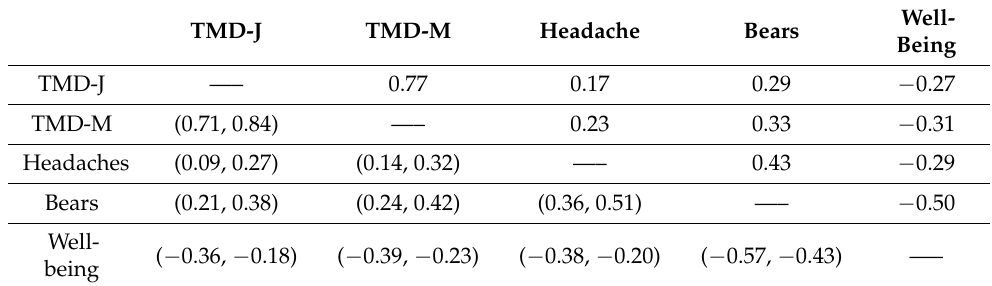
Table 6. Associations between